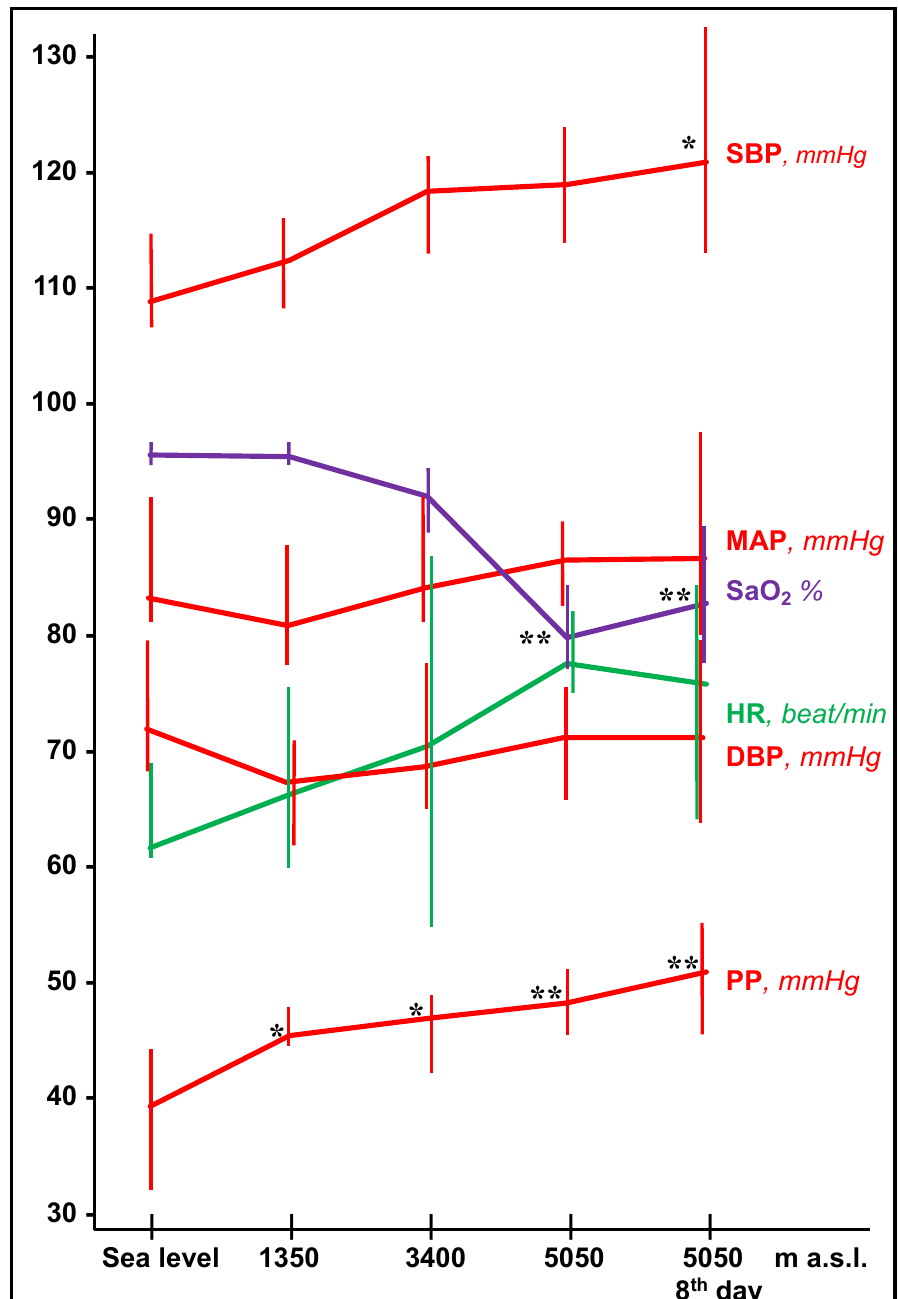
Figure 2. Heart rate (HR, green line), arterial oxygen saturation (SaO 2 , violet line), and blood pressure (red lines) changes with altitude in 8 lowlander European volunteers. Data are shown as median and interquartile range. Significance is expressed by the p -value: *, p < 0.05; **, p < 0.001 versus sea level values. a.s.l., above sea level; DBP, diastolic blood pressure; MAP, mean arterial pressure; PP, pulse pressure (= SBP − DBP); SBP, systolic blood pressure.